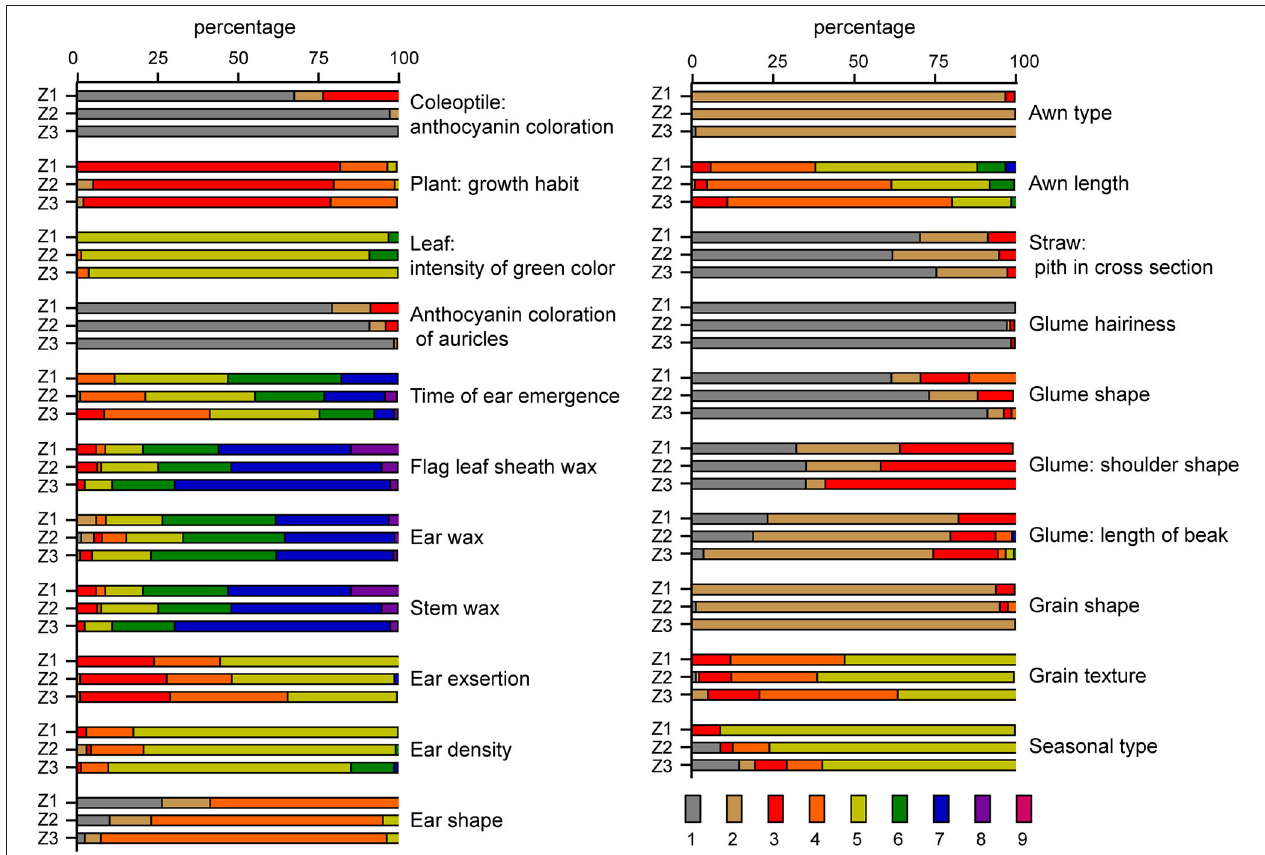
FIGURE 1 | Distribution of variation types of 21 visually assessed characteristics in 195 wheat varieties. Z1, Z2 and Z3 represent the northern winter wheat area, the north Huanghuai winter wheat area and the south Huanghuai winter wheat area respectively. Numbers 1–9 are the corresponding expression status codes assigned to the visually assessed characteristics according to the guidelines. The specific meaning of each characteristic and observation code is listed in Table 1 .